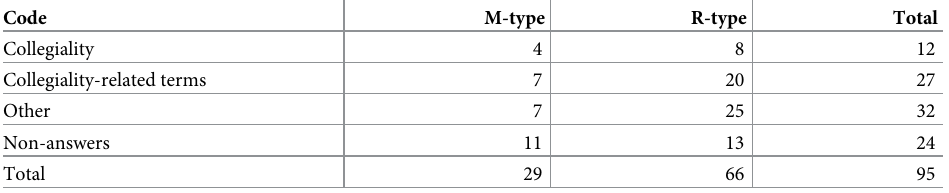
Table 3. Coding results for open-ended survey question: “Are there any other factors that you think are important for your review, promotion, or tenure?”. Code